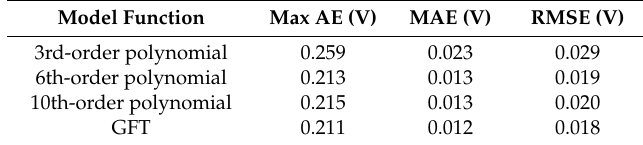
Figure 7. The comparison of voltage prediction in the WLTC test: (a) curves of terminal voltage; (b) error curves. Table 4. Error analysis of terminal voltage predicted by different model equations.